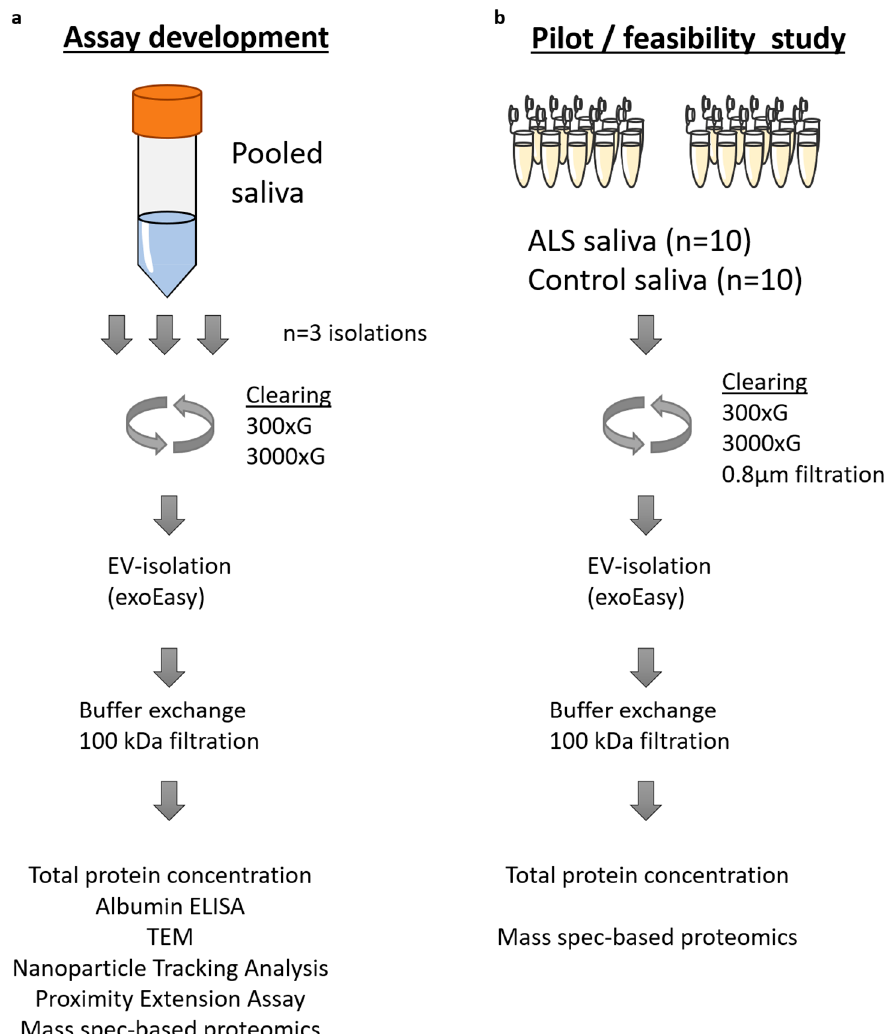
Figure 1. Study overview. ( a ) Pooled, healthy control saliva was used for assay development (90 mL × 3 isolates). The saliva was cleared using differential centrifugation followed by isolation of extracellular vesicles using exoEasy. The isolates then underwent buffer exchange using ultrafiltration. The EVs were analyzed for total protein concentration, albumin concentration, transmission electron microscopy, proximity extension assay and mass spectrometry-based proteomics. ( b ) As a feasibility and pilot study, amyotrophic lateral sclerosis and matched control saliva samples were used ( n = 10 each) with a volume ranging from 2.1 to 4.9 mL. The isolation protocol was the same except for minor changes in the clearing step. Isolated EVs and whole saliva samples were analyzed using total protein concentration measurements and mass spectrometry-based proteomics.